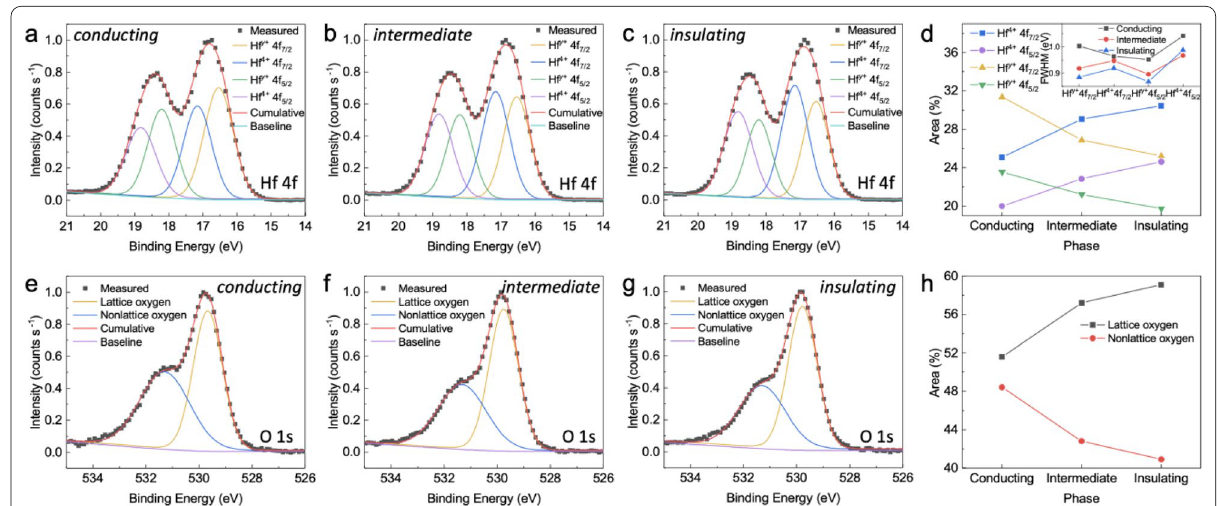
Fig. 2 XPS spectra of HfO 2- x thin films in various electrical phases. The fitting results for the Hf 4f spectra of the a conducting, b intermediate, and c insulating states are presented. d The areas of stoichiometric Hf 4 + and oxygen-deficient Hf y + spectra in different states. The inset shows the FWHM of each corresponding deconvoluted spectra. O 1 s spectra of the e conducting, f intermediate, and g insulating states are also shown. h The areas of lattice oxygen and nonlattice oxygen are in different